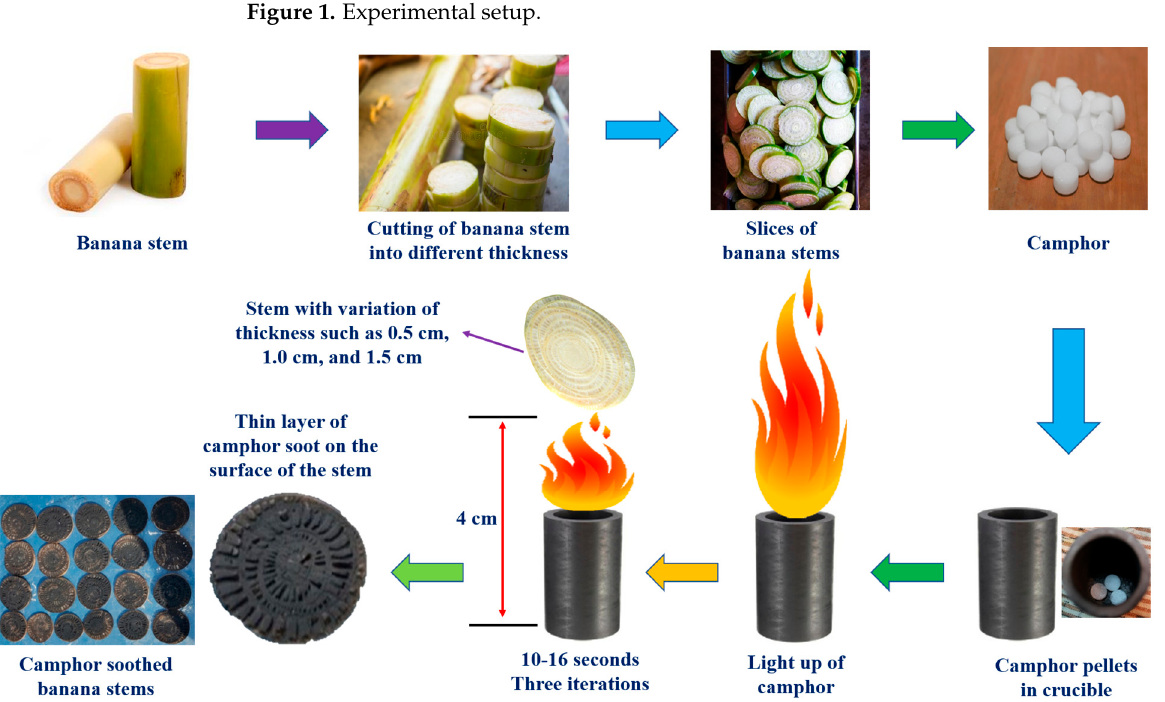
Figure 2. Process of camphor soothing of banana stems. Table 1. Measuring instruments used.